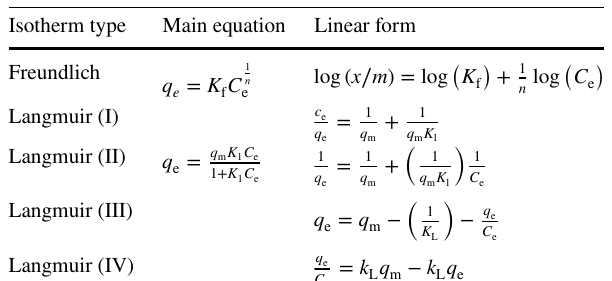
Table 2 Equations of isotherms Isotherm type Main equation Linear form